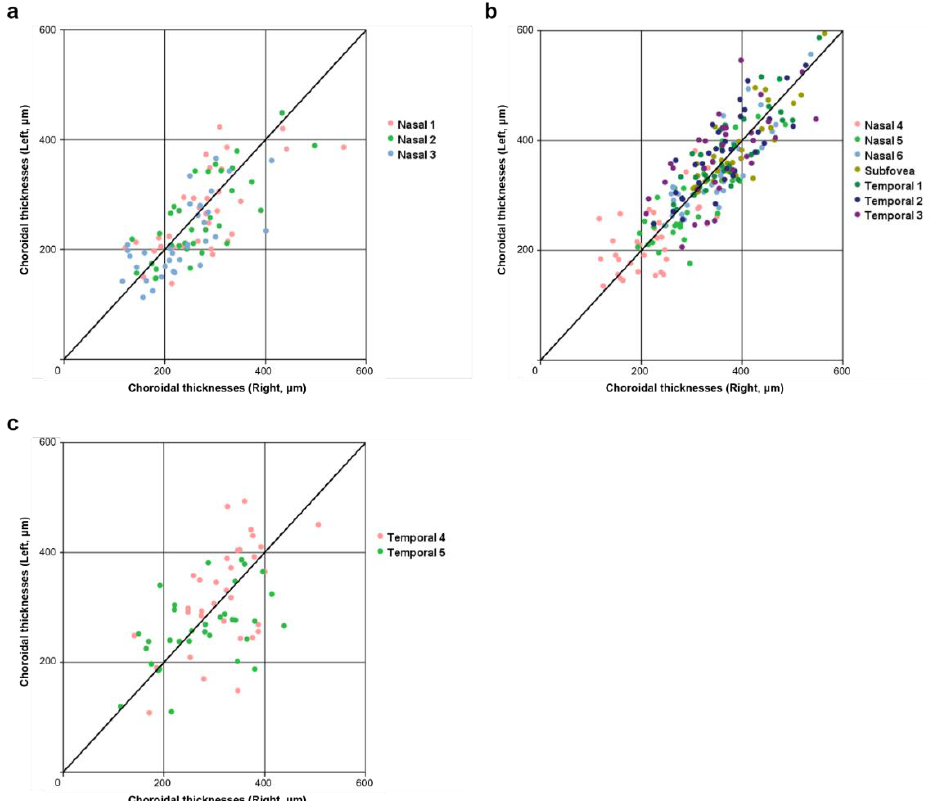
* Comparison of choroidal thickness between the right and left eyes by paired t test. CV, coefficient of variation; ICC, interclass correlation coefficient; ρ . Pearson’s correlation coefficient; SD, standard deviation.